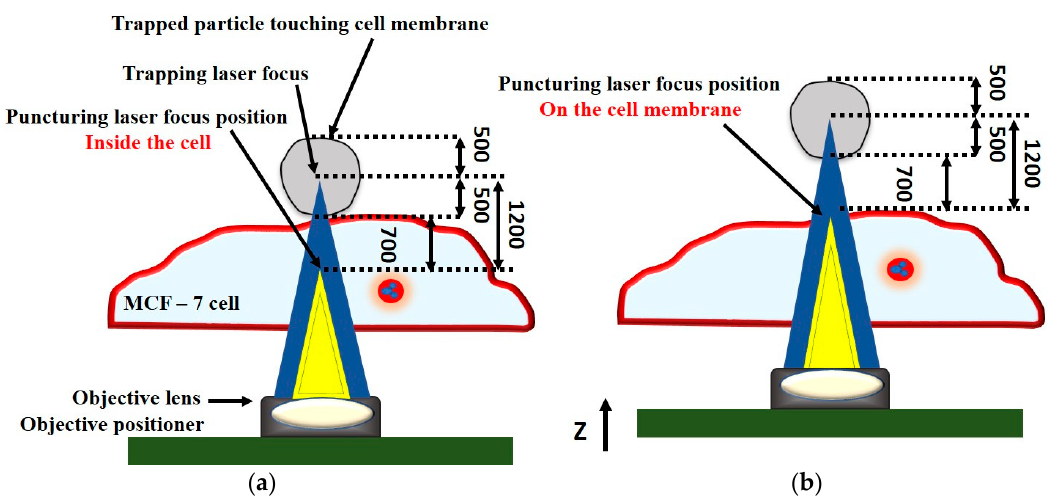
Figure 23. Schematic representation of particle intracellular delivery. ( a ) 1064 nm laser (blue) is used as an optical tweezer to trap particle. ( b ) An 800-nm femtosecond laser (yellow) is used as a puncturing laser to create pore on cell membrane. Redrawn from [166].